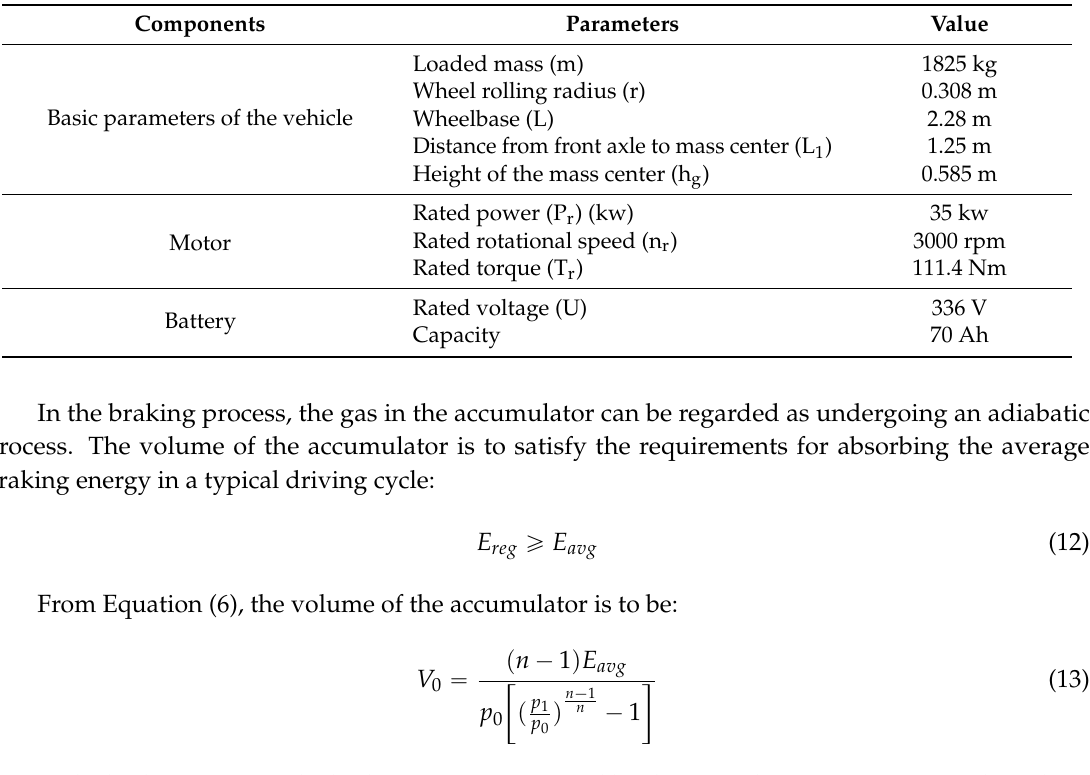
Table 2. Basic Parameters of the Power Transmission